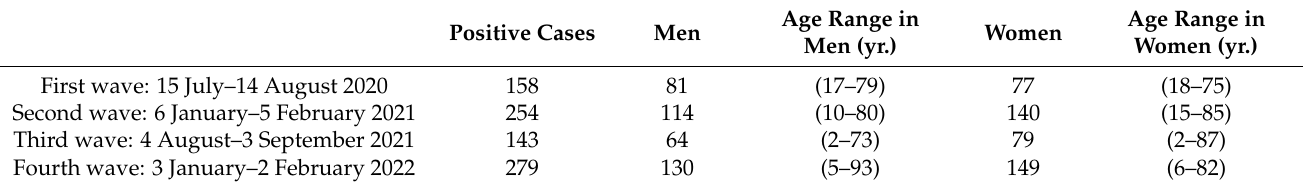
Table 1. Number of people infected and analyzed through the GIS model during the period estab- lished in the four waves of COVID-19.